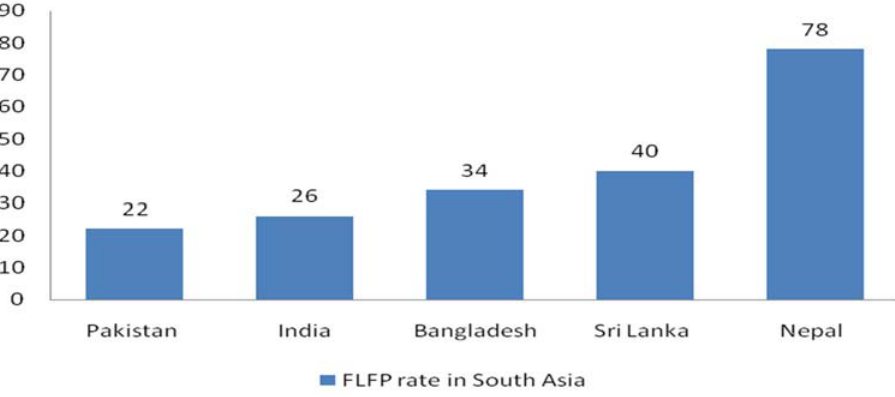
Figure 3. South Asian FLFP rate. World Bank